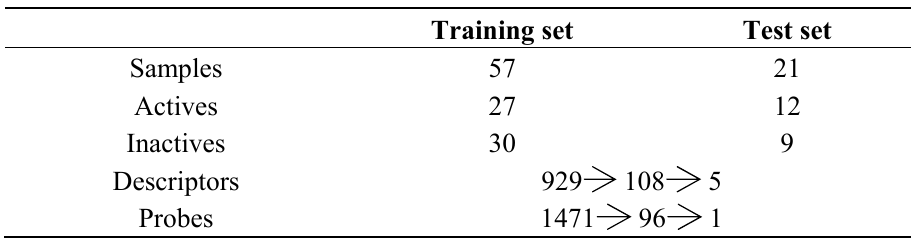
Table 2. Summary of dataset.